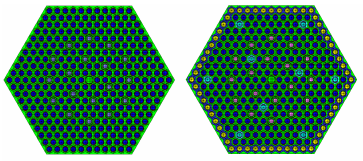
Figure 4. Inputs of F130/F200 (left) and inputs of FF36G9/FF40G9 (right).